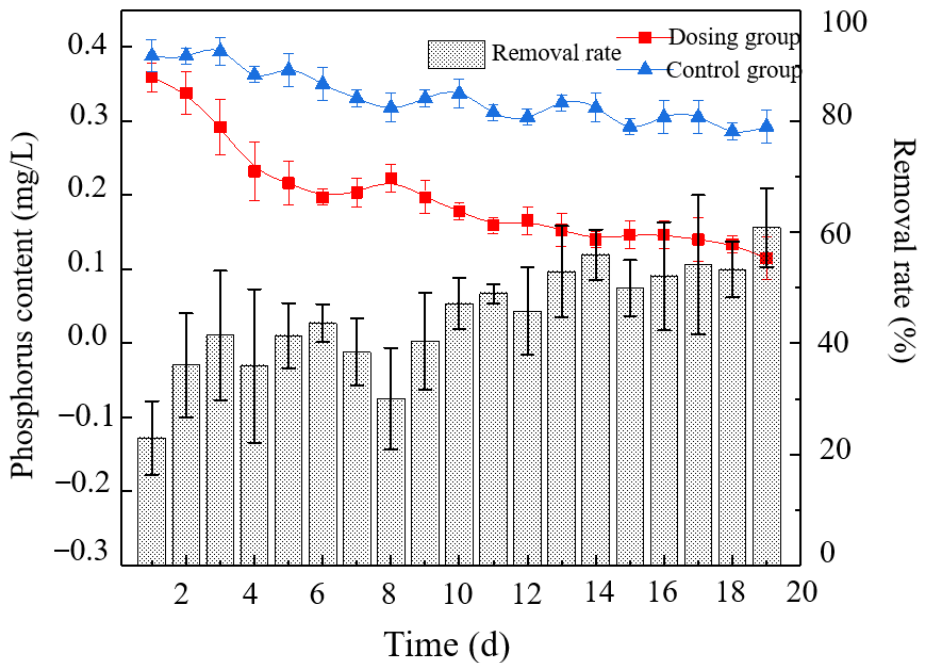
Figure 7. Comparison of orthophosphate control effect.